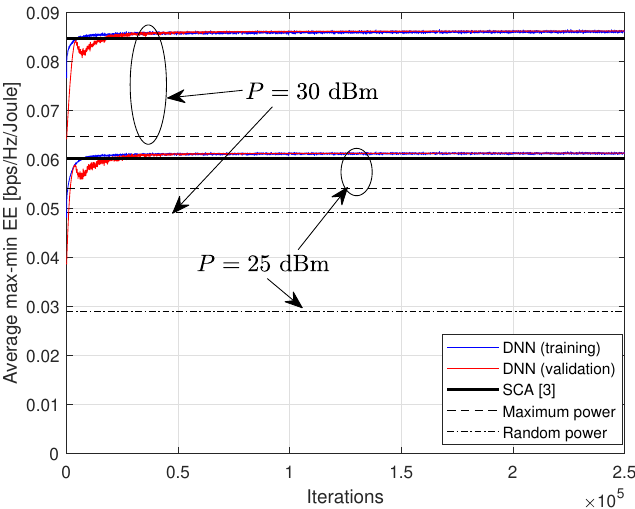
Figure 4. Convergence of training and validation performance with K = 2 and P C = 33 dBm for different P